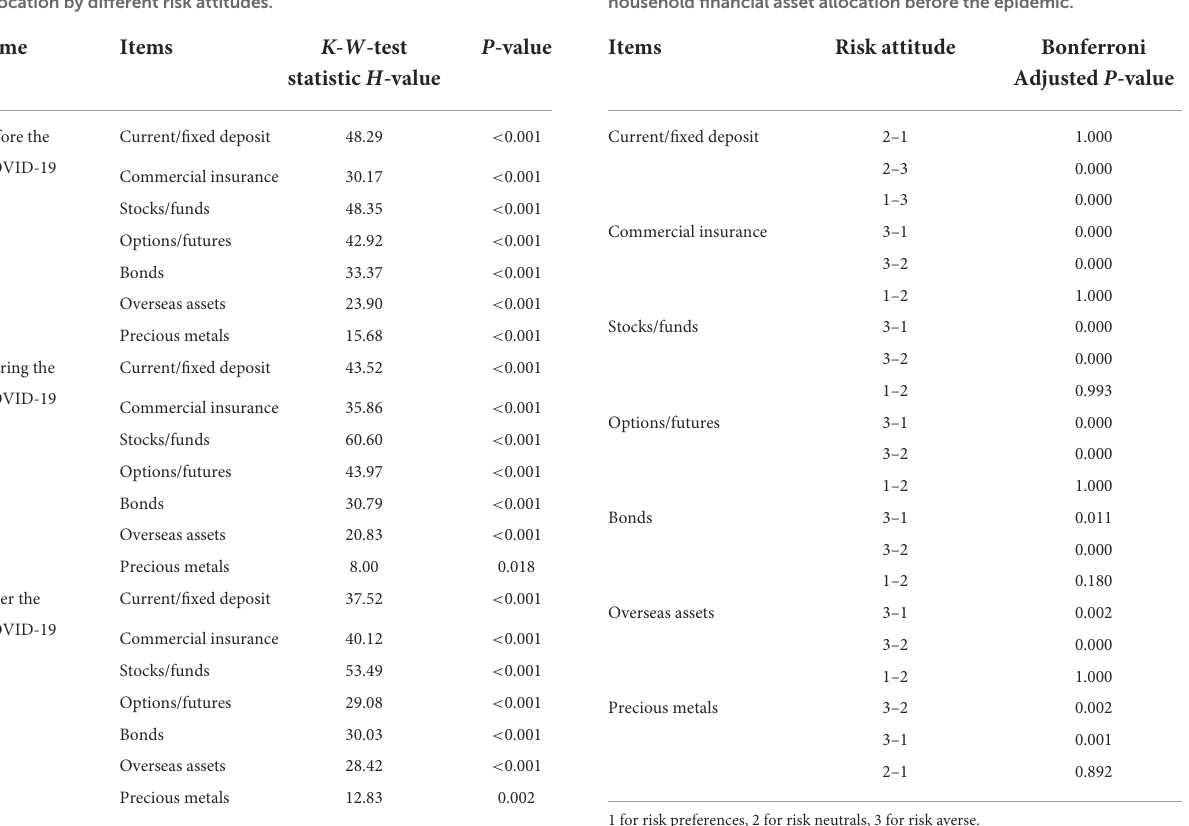
TABLE 8 Analysis of the differences in household financial asset allocation by different risk attitudes.